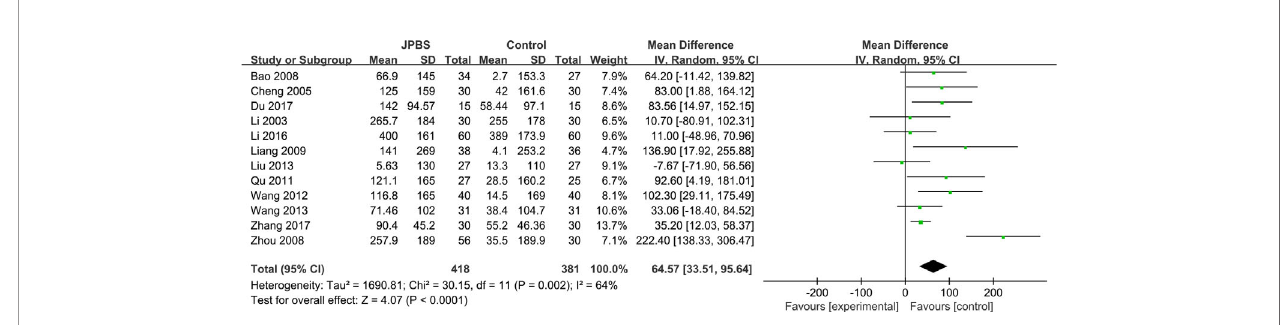
FIGURE 9 | Forest plot of SCr levels.